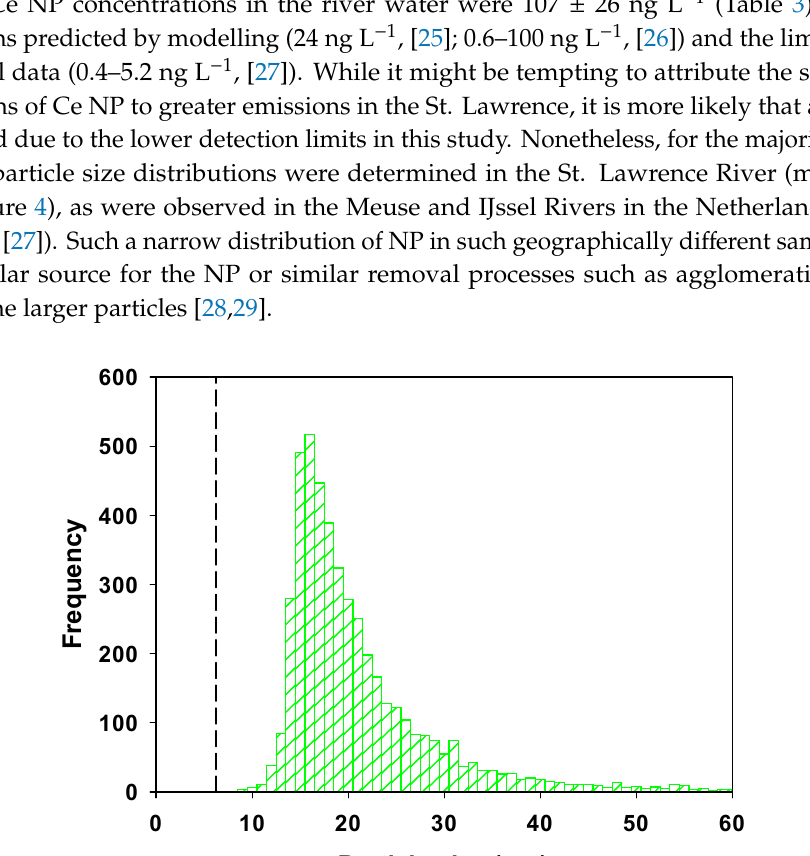
Particle size (nm)